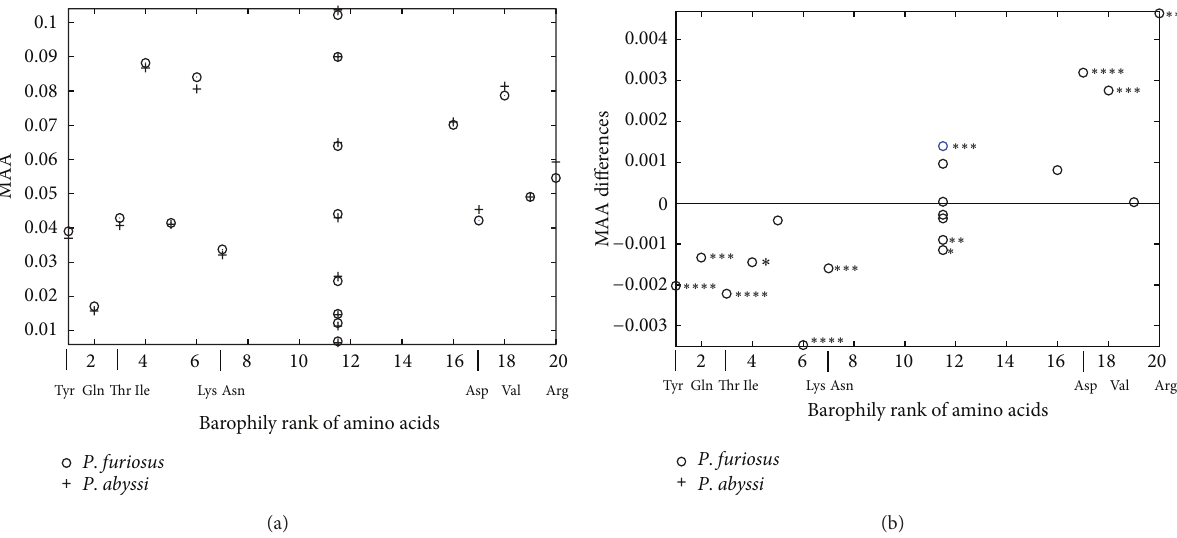
Figure 3: Mean relative amino acid abundance (MAA) analysis of the set of entire polypeptide sequences. (a) On average, both Pyrococci seem to use barophilic and nonbarophilic amino acids to the same extent. (b) The barophilic Asp, Val, and Arg are used significantly more in sequences of the barophilic P. abyssi compared to the nonbarophilic P. furiosus (positive difference), whereas the nonbarophilic Tyr, Gln, Thr, Ile, Lys, and Asn are used significantly more in P. furiosus compared to P. abyssi (negative difference). Statistical significance is marked with stars according to Welch’s two-sided test: ∗ 𝑃 < 0.1; ∗∗ 𝑃 < 0.01 ; ∗∗∗ 𝑃 < 0.001 ; ∗∗∗∗ 𝑃 < 0.0001 . A total of 1,896 P. abyssi and 2,125 P. furiosus sequences were analyzed.